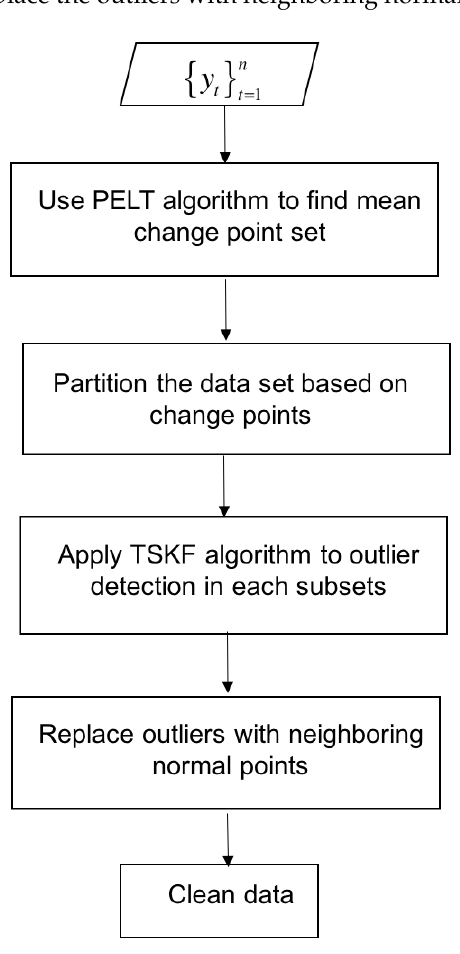
Figure 2. An integrated outlier detection algorithm